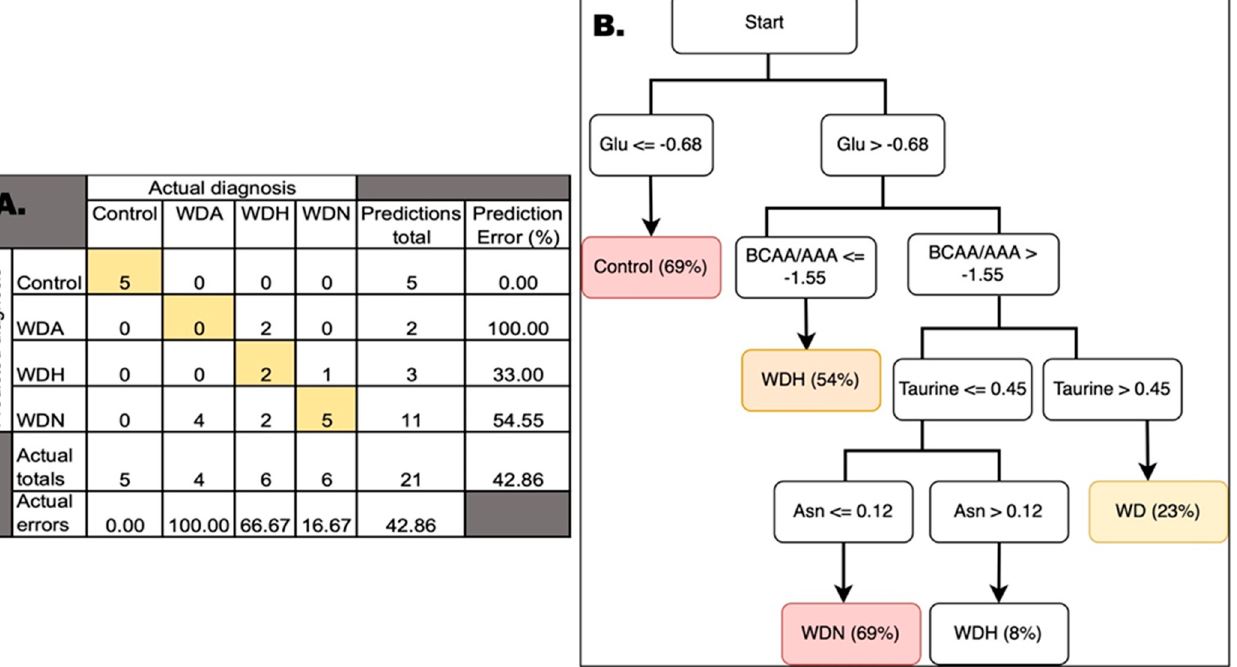
Figure 1. Confusion matrix and decision tree for the diagnosis of WD and its manifestations by using artificial neural network. ( A ). The testing samples ( n = 21) were “trained” by using the trained ANN obtained with the training set. By applying a simplified fuzzy adaptive resonance theory map, the top part of the table shows the actual diagnosis vs. the predicted one. Numbers in boxes represent the number of subjects except for errors which are expressed in percentages. Colored boxes are those matching the actual and predicted diagnoses. ( B ). Decision tree showing the main outcomes needed to be tested in order to reach the diagnosis of WD and its phenotypes. Diagnosis confidences (in percentage) are stated between parentheses. Other details are found in the text.